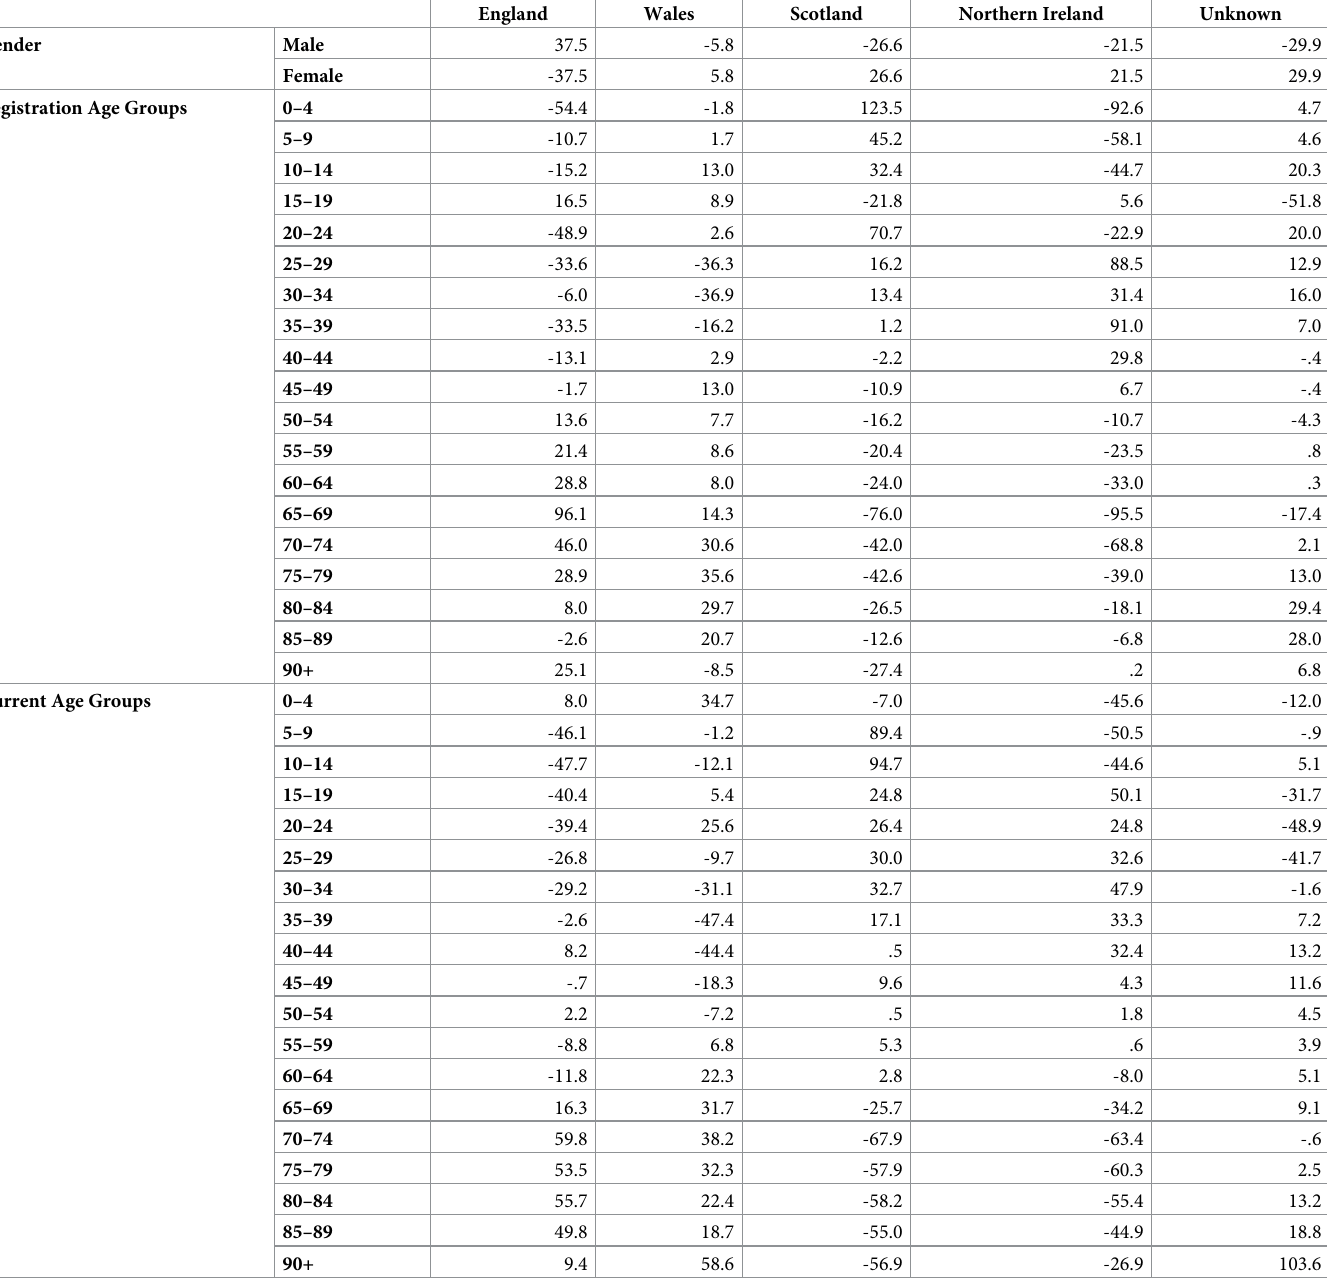
Table 5. Chi 2 test of independence adjusted residuals for nation with age groups and gender (analysed using dataset 1 –March